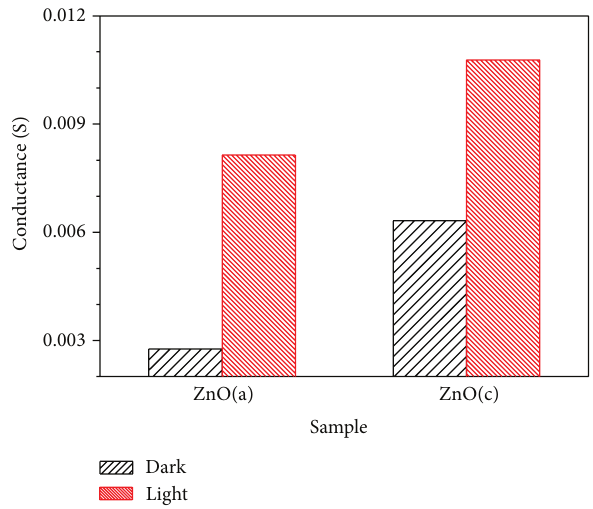
Figure 5: Conductance of ZnO thin films grown on a-plane and c- plane